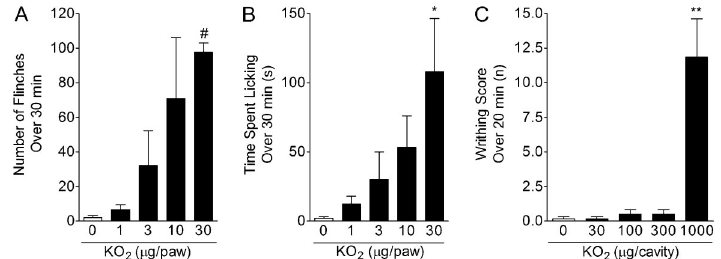
Figure 2. KO 2 induced overt pain-like behavior. The number of paw flinches ( A ), and the time spent licking the paw ( B ) were evaluated during 30 min after KO 2 (1-100 m g, ipl ) or saline injec- tion. The writhing score was evaluated 20 min after KO 2 (30-1000 m g, ip ) or saline injection. Data are reported as means±SE. *P , 0.05 vs saline control; # P , 0.05 vs 1 m g; **P , 0.05 vs 300 m g (one-way ANOVA followed by Tukey’s t - test).